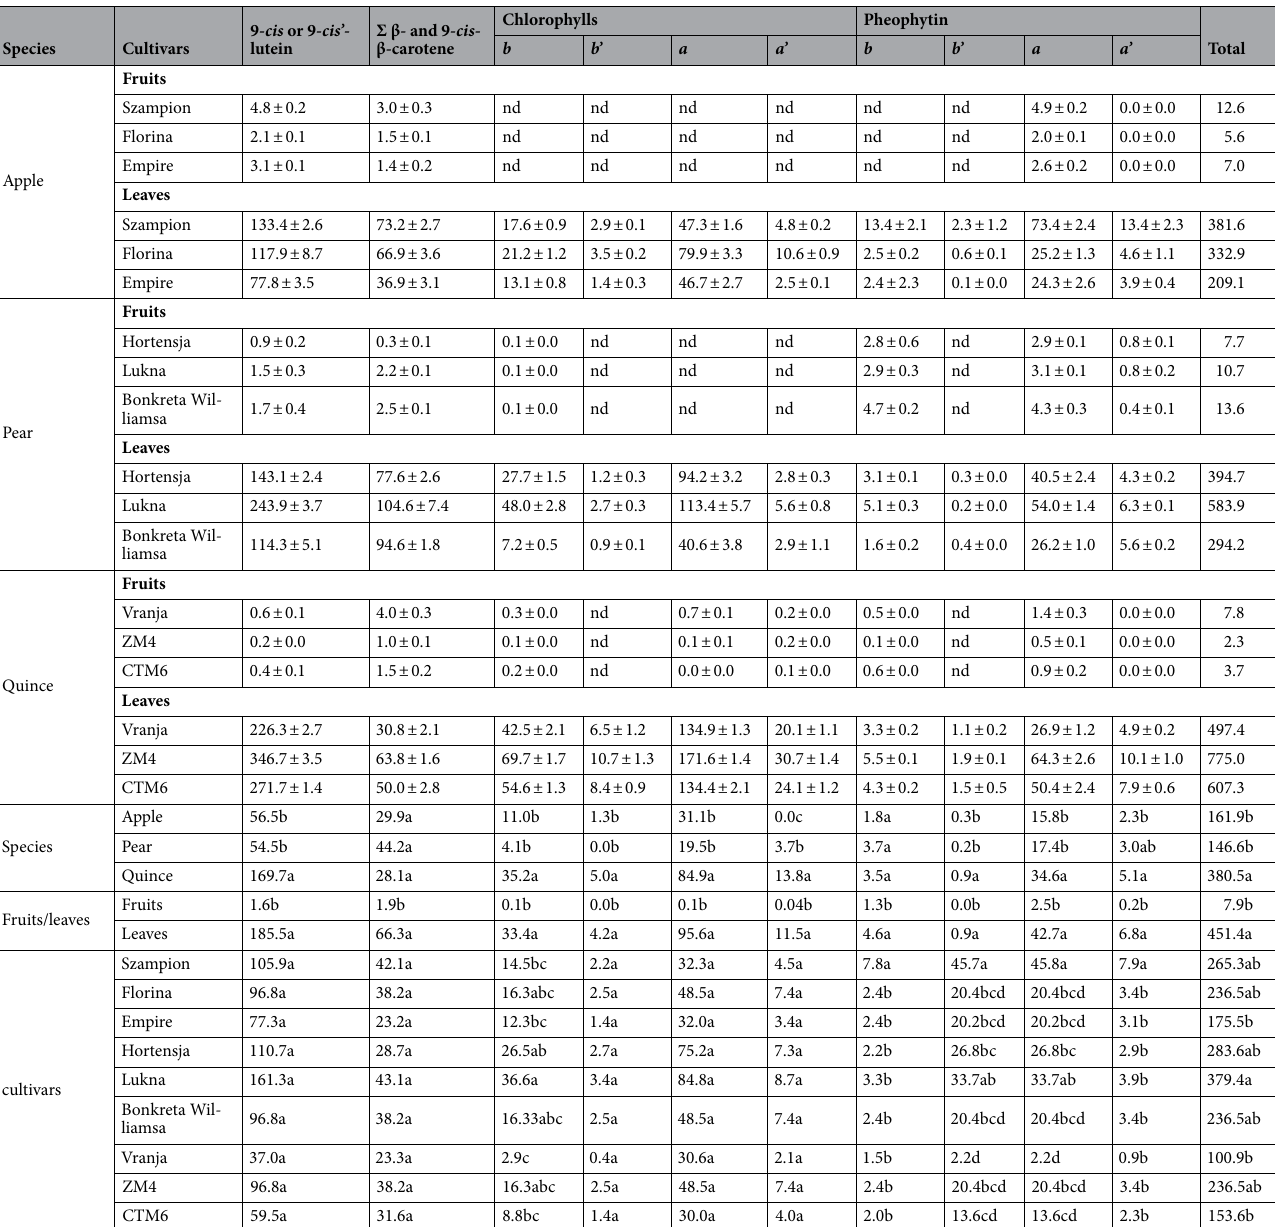
Table 2. Comparison of isoprenoids (carotenoid and chlorophylls; mg/100 g dw) content in fruits and leaves of some selected species and cultivars of apple, pear, quince fruits and leaves. Mean of 3 replications ± standard deviation followed by the same letter, within the same column were significantly different (p < 0.05) according to Tukey’s least significant differences test. Letters a,b,c,d, represent significance in content (p < 0.05). nd not